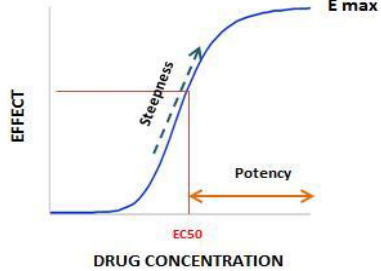
Figure 1. The relationship between drug concentration and effect can be explained by a sigmoidal curve. The maximum effect is reached when a further increase in concentration does not result in higher response (plateau point). The EC50 is the drug concentration required to achieve 50% of the effect and it is in relationship with drug Potency. Hill coefficient ( γ ) determines ‘steepness’ of the effect versus concentration curve, giving information on the interactions between ligand and binding sites. In fact, the curve can be steeper (if the value of γ is greater than one) or shallower (if the value of γ is lower than one) .